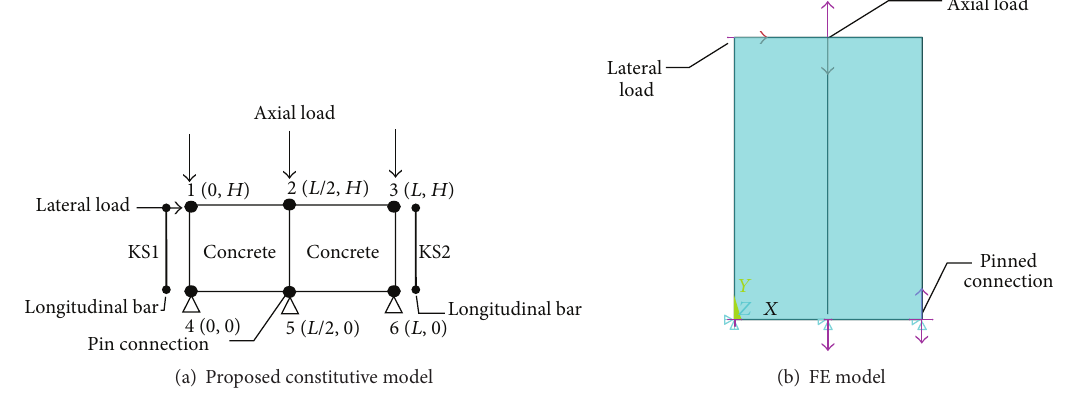
Figure 6: One concrete segment model